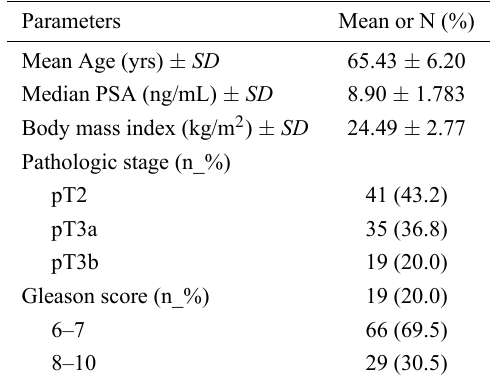
Table 1. Patients’